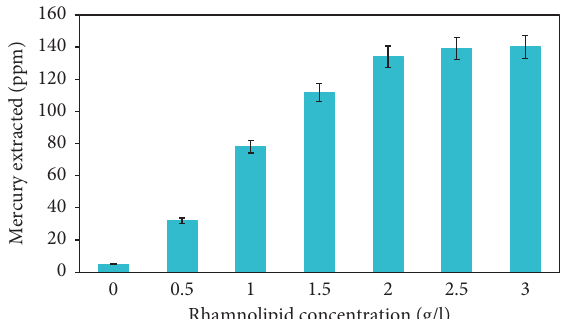
Figure 5: Effect of rhamnolipid concentration on mercury extraction.